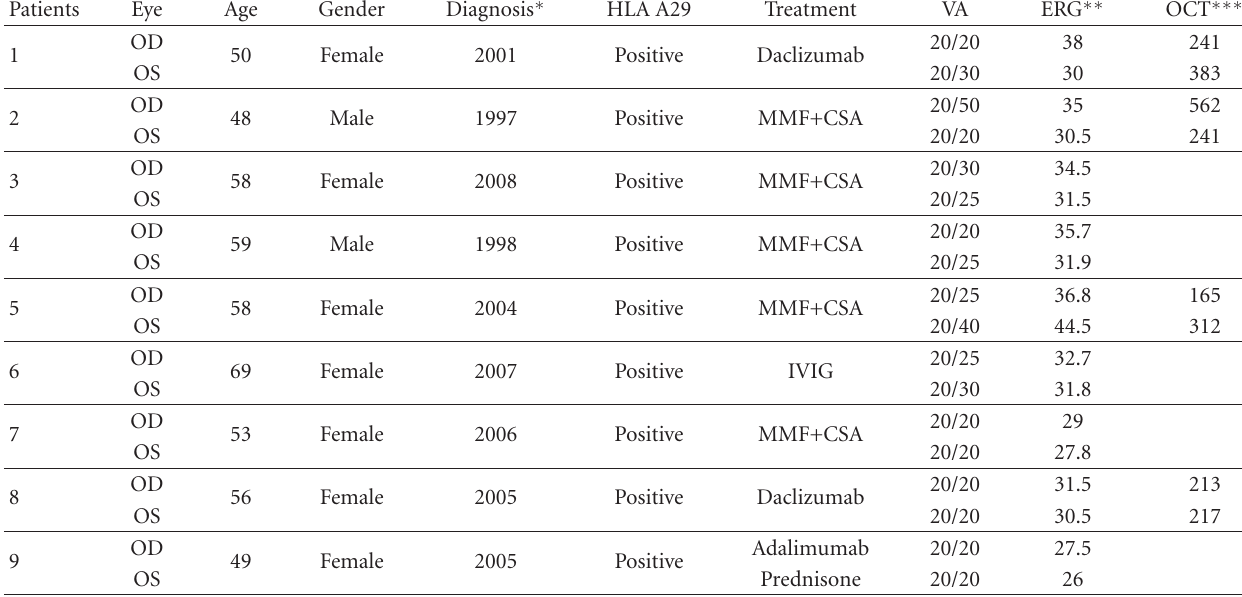
Table 1: Demographic